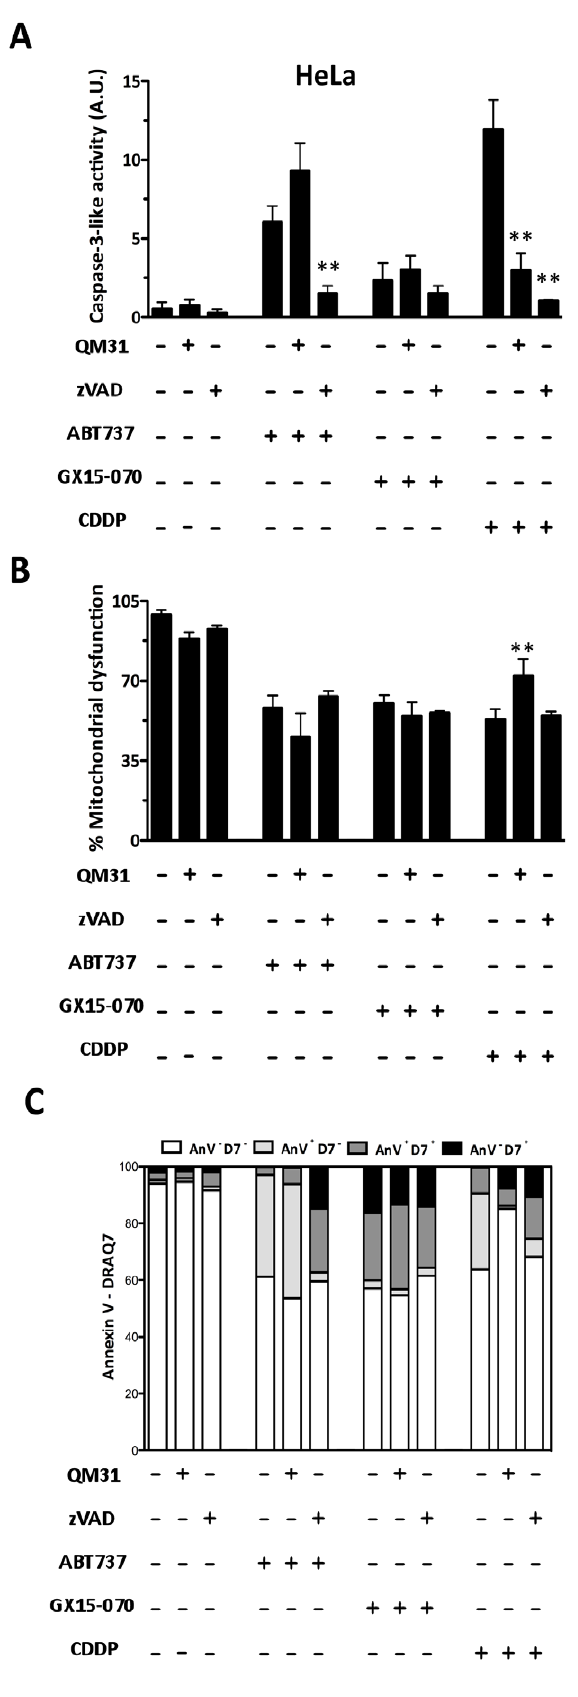
Figure 4. Apaf-1 inhibition does not protect tumor HeLa cells from death induced by ABT737 and GX15-070. ( A ) Caspase 3-like activity was measured in the HeLa cells treated with ABT737 (25 m M), GX15-070 (1 m M) and CDDP (30 m M) in the presence or absence of QM31 (10 m M) and zVADfmk (5 m M). ( B ) Mitochondrial dysfunction was measured by an MTT assay under the same conditions described above. Bars represent the mean of three experiments 6 s.d. (* p , 0.1; ** p , 0.05). ( C ) Apoptotic cell death was analyzed by flow cytometry with FITC Annexin V and DRAQ7. Data are representative results of three independent